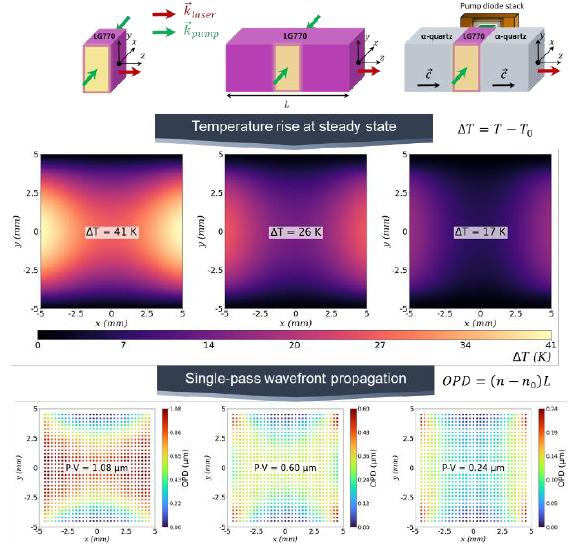
Fig. 1: (Color online) (Top) Sketches of the bonded structure and the control samles. (Middle) Temperature profiles at the center of each gain medium at steady-state. (Bottom) Resulting distorted wavefront after a single-pass.